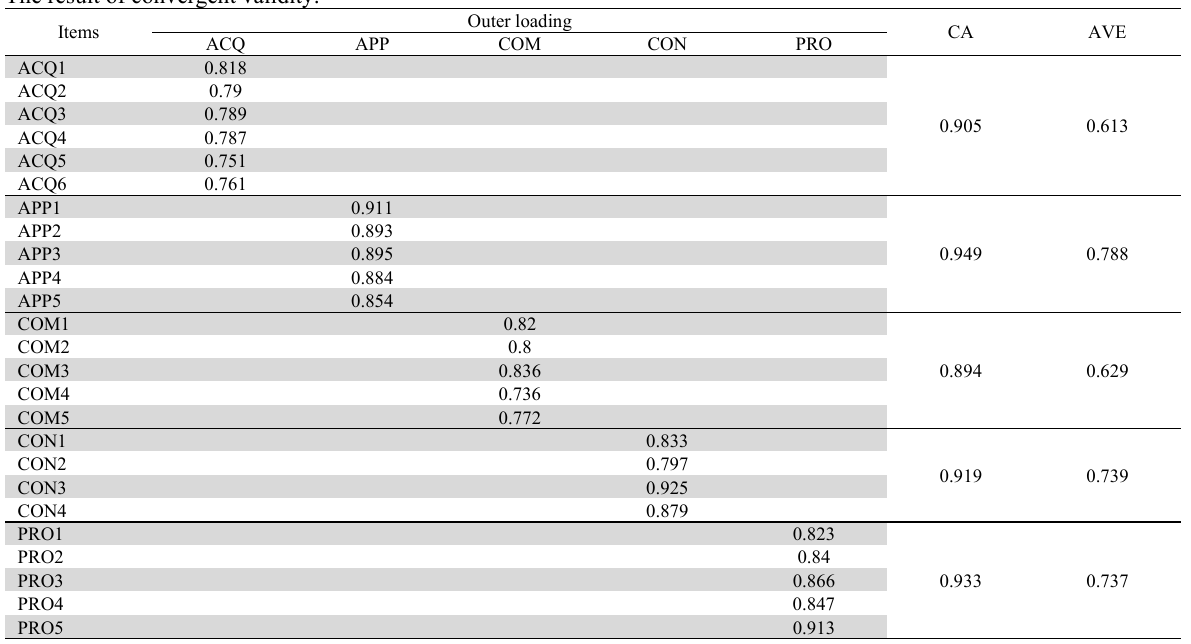
The result of convergent validity.